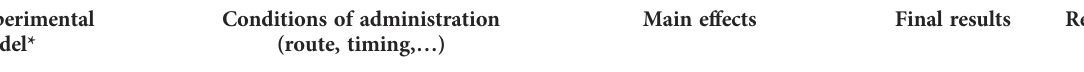
TABLE 1 Consequences of SuperMApo treatment in different experimental models of acute and chronic in fl